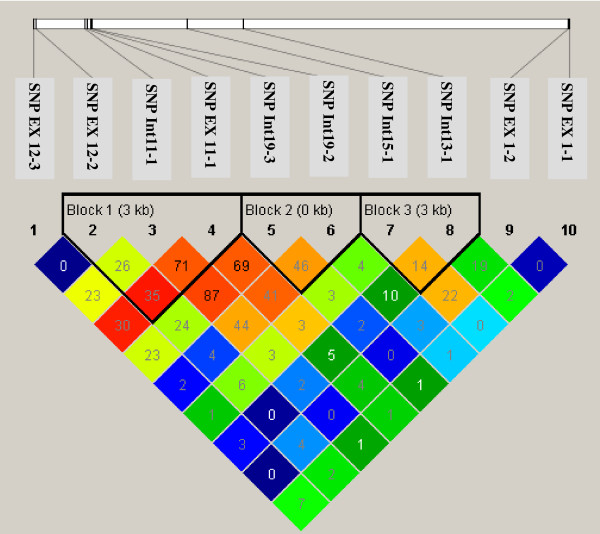
Haplotype block of 10 identified SNPs in UGDH.